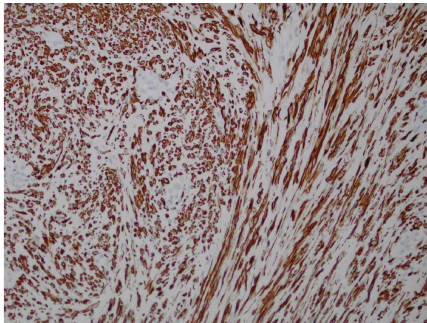
Figure 3: Immunohistochemical stain for smooth muscle desmin.